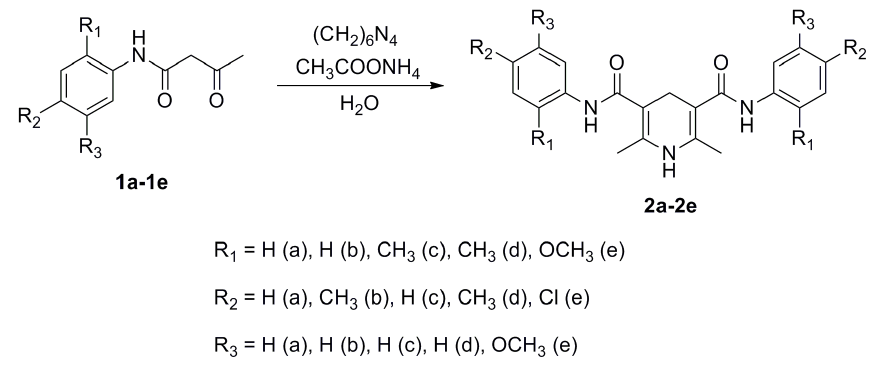
Figure 1. Synthetic routes of compounds a–e.